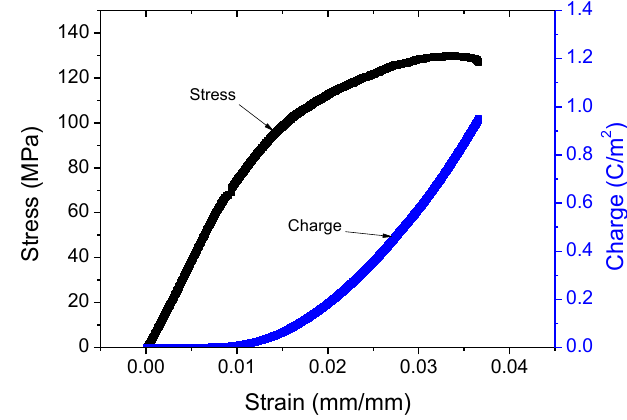
Figure 6. Stress-strain and charge curves of